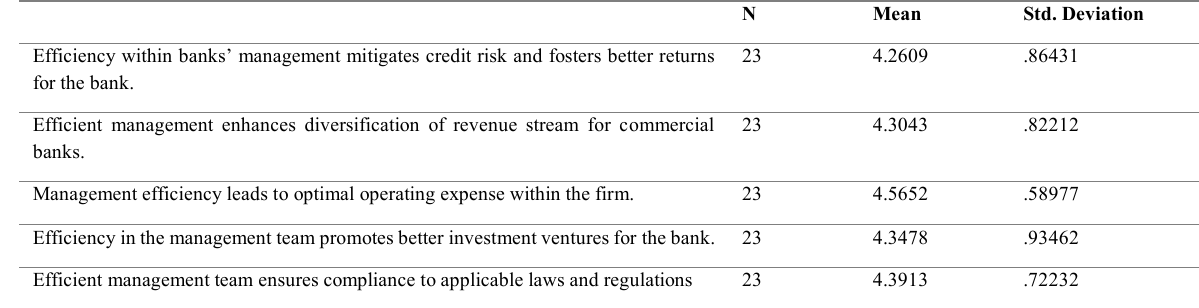
Table 3: Management efficiency and financial